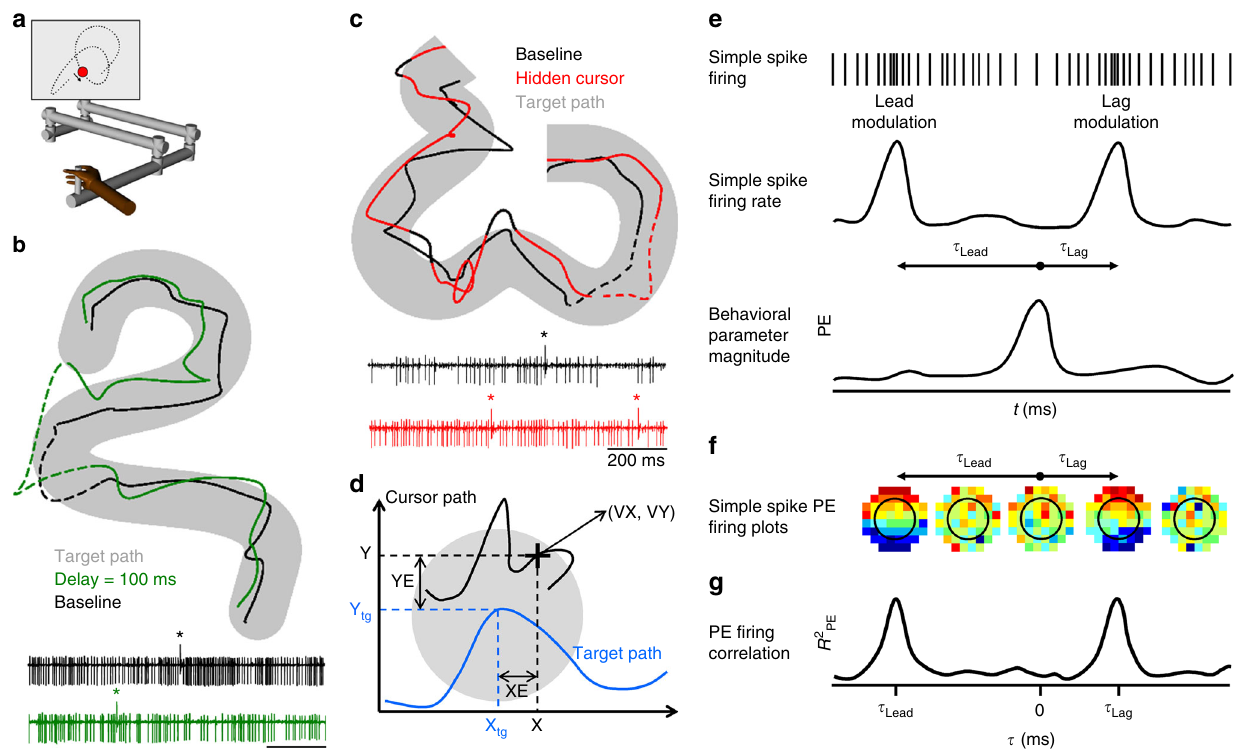
Fig. 1 Experimental setup, example Purkinje cell recordings during visual feedback manipulations, and analysis steps. a Monkeys use a manipulandum to track a circular target (red circle) moving pseudo-randomly (target trajectory depicted by dotted line) on a computer screen. Image modi fi ed from Streng et al. 21 . b Cursor path in baseline (black trace) and delay conditions (green trace) while the monkey tracked the target moving on the same trajectory (gray area). Example Purkinje cell activity recorded during delay (green) and baseline (black) conditions during the 1 s dashed segments of the trajectories. Complex spikes marked by ‘ * ’ . c Cursor path in baseline (black trace) and hidden (red trace) conditions while the monkey tracked the target moving on the same trajectory (gray area). In the hidden condition, the animal does not see the cursor when it is inside the target (red portion of the cursor movement). The cursor is visible only when it is outside the target (black portion of the cursor movement). Example Purkinje cell activity recorded during baseline (black) and hidden (red) conditions during the 1 s dashed segments of the trajectories. d Behavioral parameters analyzed. Target path (gray circle) is depicted by the blue trace. Hand movement is mapped onto the cursor movement (black trace). Movement kinematics are described by position (X, Y) and the velocity vector (VX, VY). Position error (XE, YE) is the difference between cursor position (X, Y) and target center (X tg , Y tg ). e Illustration of the analysis steps. Cartoon of simple spike train (top panel) is transformed to a mean-subtracted continuous fi ring rate (middle panel) and correlated with the behavior parameters (bottom panel). Arrows in the middle panel illustrate the lead and lag relations ( τ ) between SS modulation and behavior. PE: position error. f Example of mean-subtracted SS fi ring rate across all trials, binned and averaged in 8 × 8 partitions in relation to behavior (PE in this illustration) at both lead and lag τ -values. Red colors indicate higher discharge rates. g Temporal linear regression analysis results in R 2 as a function of τ that quanti fi